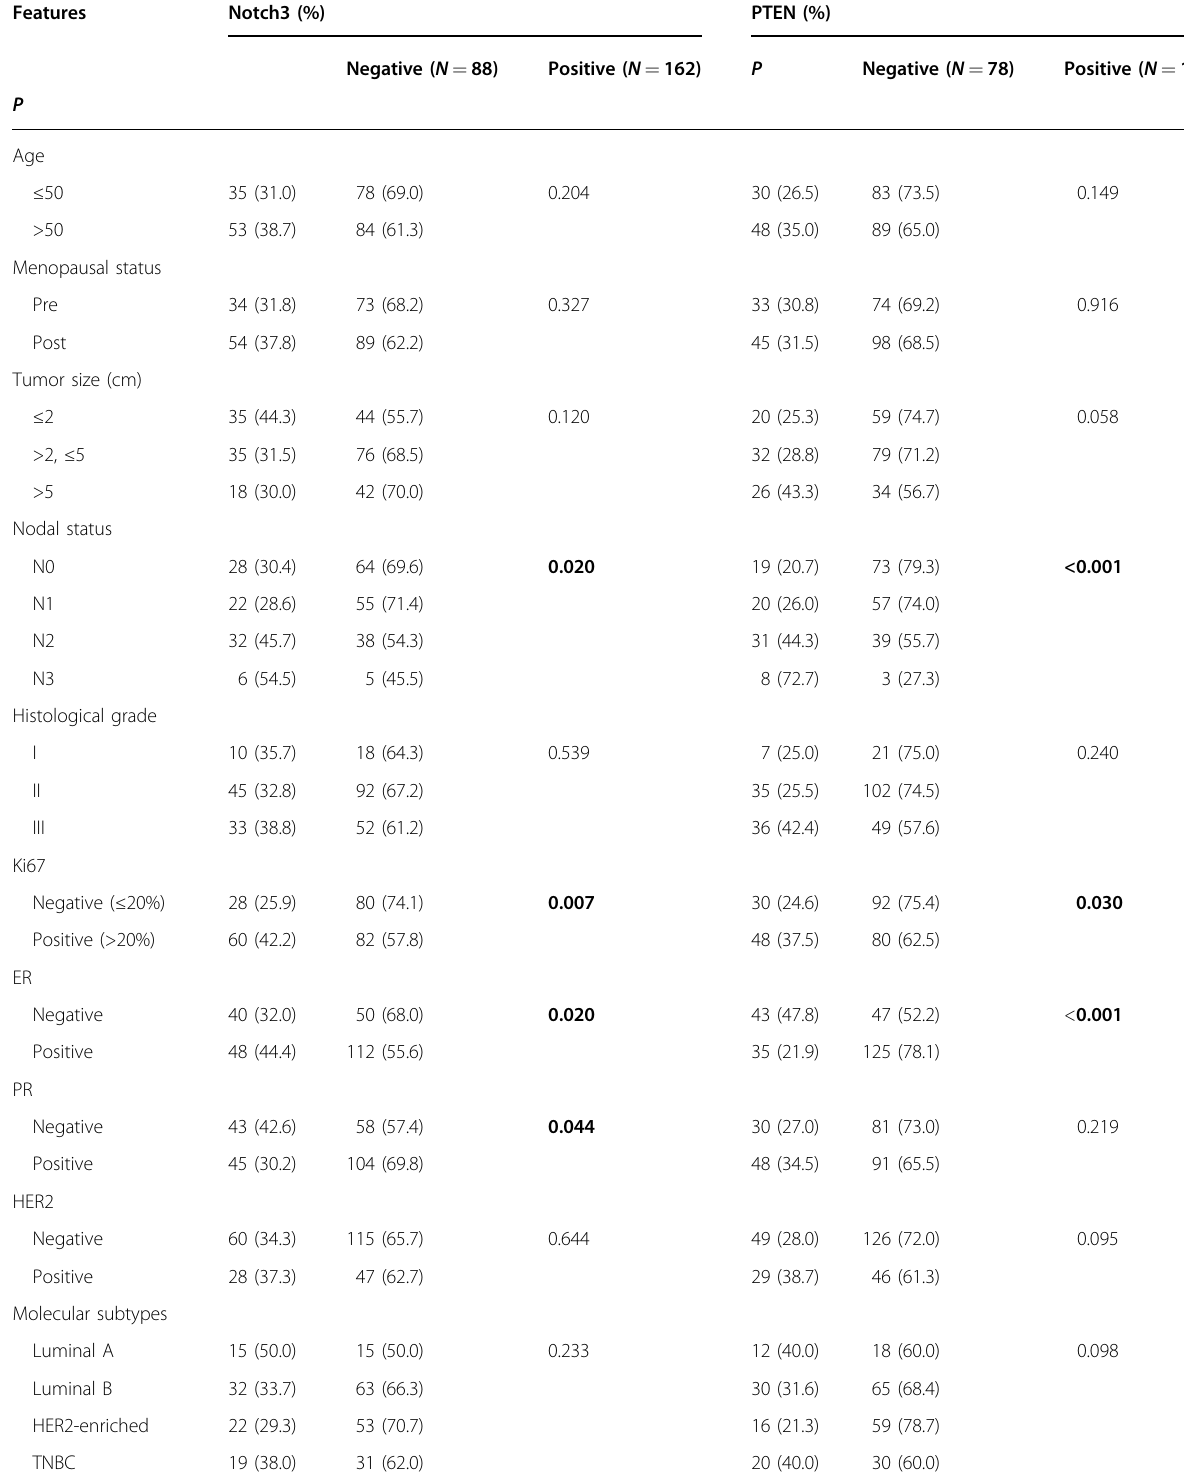
Table 1 Association between clinicopathological characteristics and Notch3 or PTEN expression in breast cancer